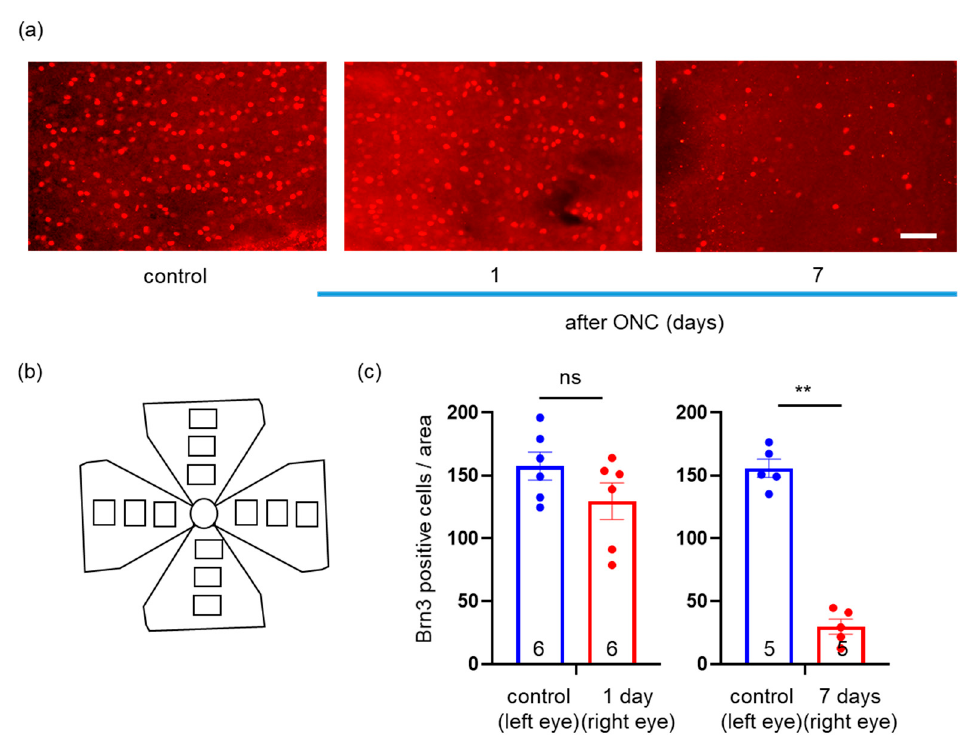
Figure 2. ( a ) Immunohistochemistry of Brn3 in the flat-mounted retinal section. Left panel: control; middle panel: 1 day after ONC; right panel: 7 days after ONC. Brn3 protein shown in red circluar staing in nucleus. Bar, 100 μ m. ONC: optic nerve crush. ( b ) Schema of the areas (1593.75 μ m × 1200 μ m) in which we counted Brn3-positive cells. The areas (blocks) were the proximal (250 μ m from the optic nerve head), middle (800 μ m from the optic nerve head), and peripheral (100 μ m from the ora serrata) areas of each quadrant. ( c ) The average counts in the 12 areas per retina. The number of retinas used in each group for quantification is indicated in the graphs. Data are presented as the mean ± SEM. ** p < 0.01, ns = not significant.